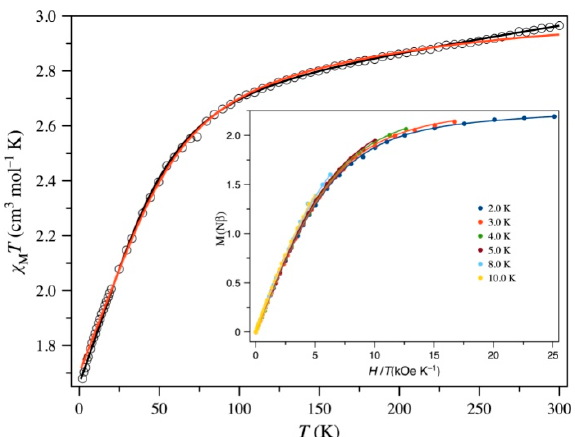
Figure 3. M T vs. T and the reduced M vs. H plots (inset) for 1 : (empty and filled circles) experimental; (solid lines) best-fit curves to the experimental data by using the parameters reported in the text for the 1st order SOC (black) and zfs (red) approaches.